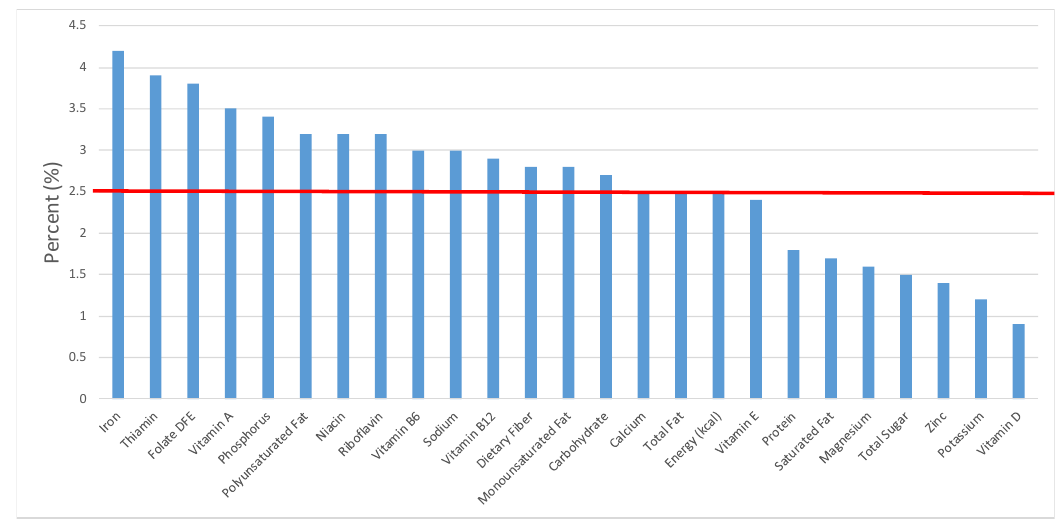
Figure 21. Quick breads and bread products as sources of energy and nutrients for children and adolescents 2–18 years old ( N = 6109, daily intake data): DFE = Dietary Folate Equivalents; solid red line represents percentage of energy (kcal) provided in the diet relative to nutrients—nutrients above the red line show the grain food’s contribution to nutrient density.